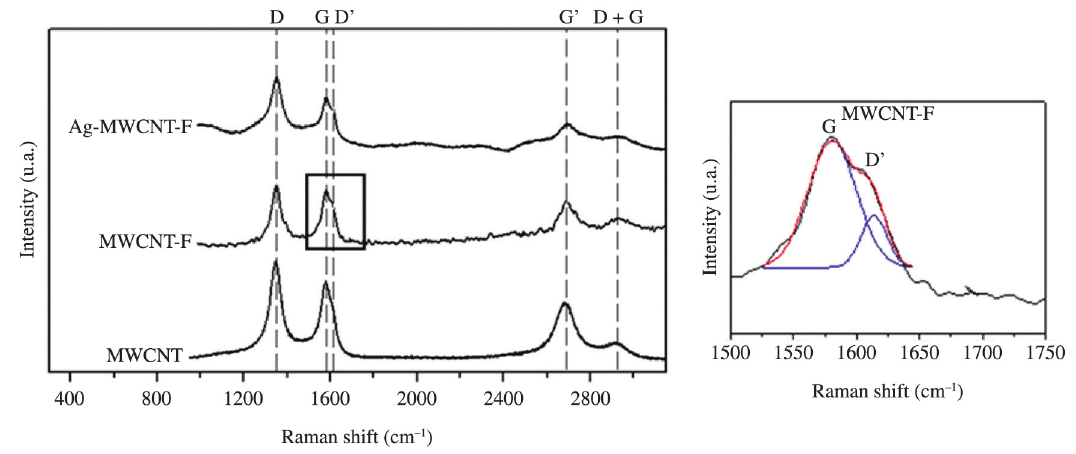
Figure 5. Raman spectroscopy results performed on MWCNT, after each of the two steps Ag decoration procedure. Spectrum from pristine MWCNT is also present, for comparison purpose. Peak deconvolution in the range of 1500-1750 cm –1 is shown in detail, revealing the individual contribution of G and D’ intensities in the MWCNT-F spectrum.